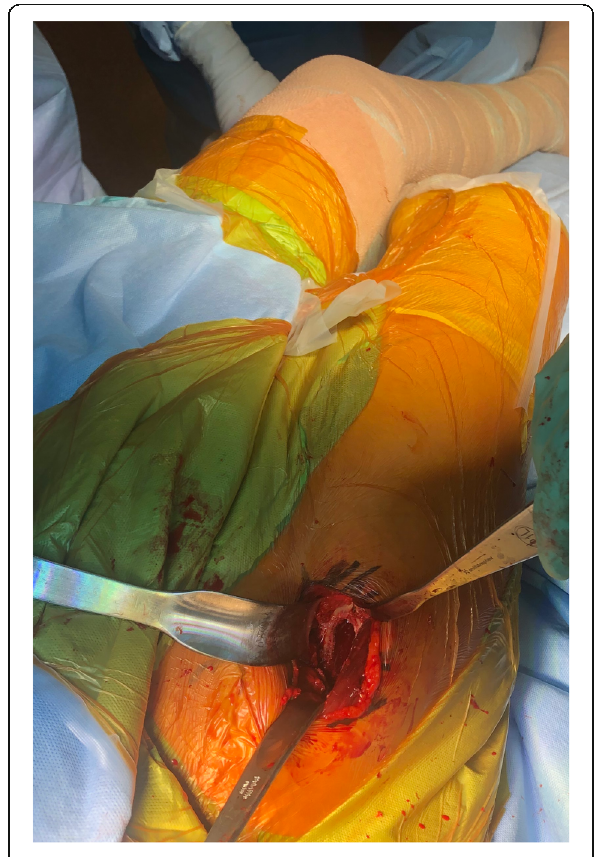
Fig. 2 Surgeon ’ s view of the proximal femur during a bikini DAA THA with the table-break providing hip